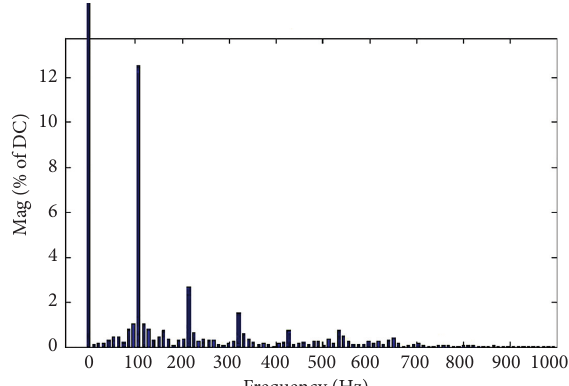
Figure 23: FFT magnitude spectrum of the radial oscillation when the rotor was running at 6000rpm.